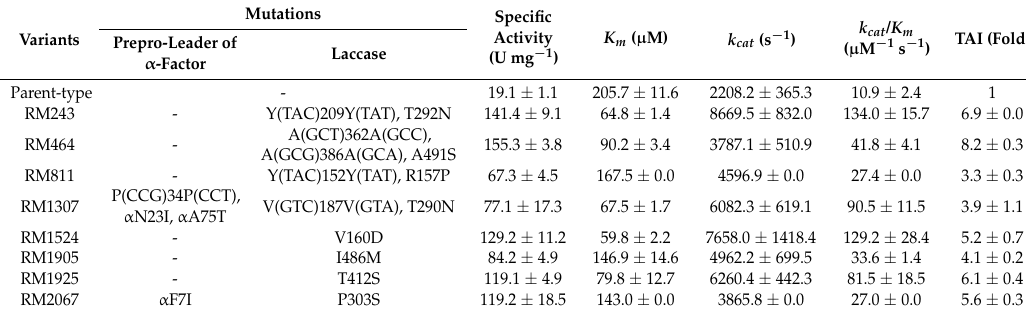
Table 1. Comparison of the kinetics parameters of evolved laccases from the random mutagenic library at pH